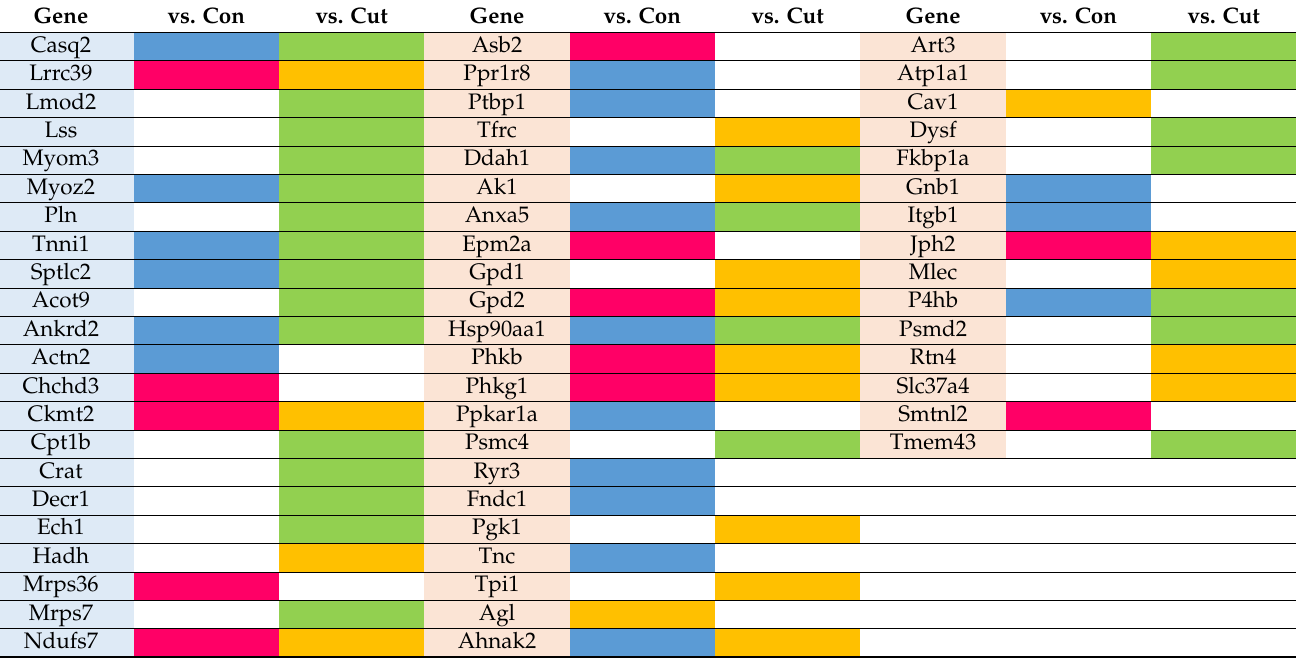
Table 1. Correspondence between the genes identified by Murgia et al. and the genes that were differentially expressed in this